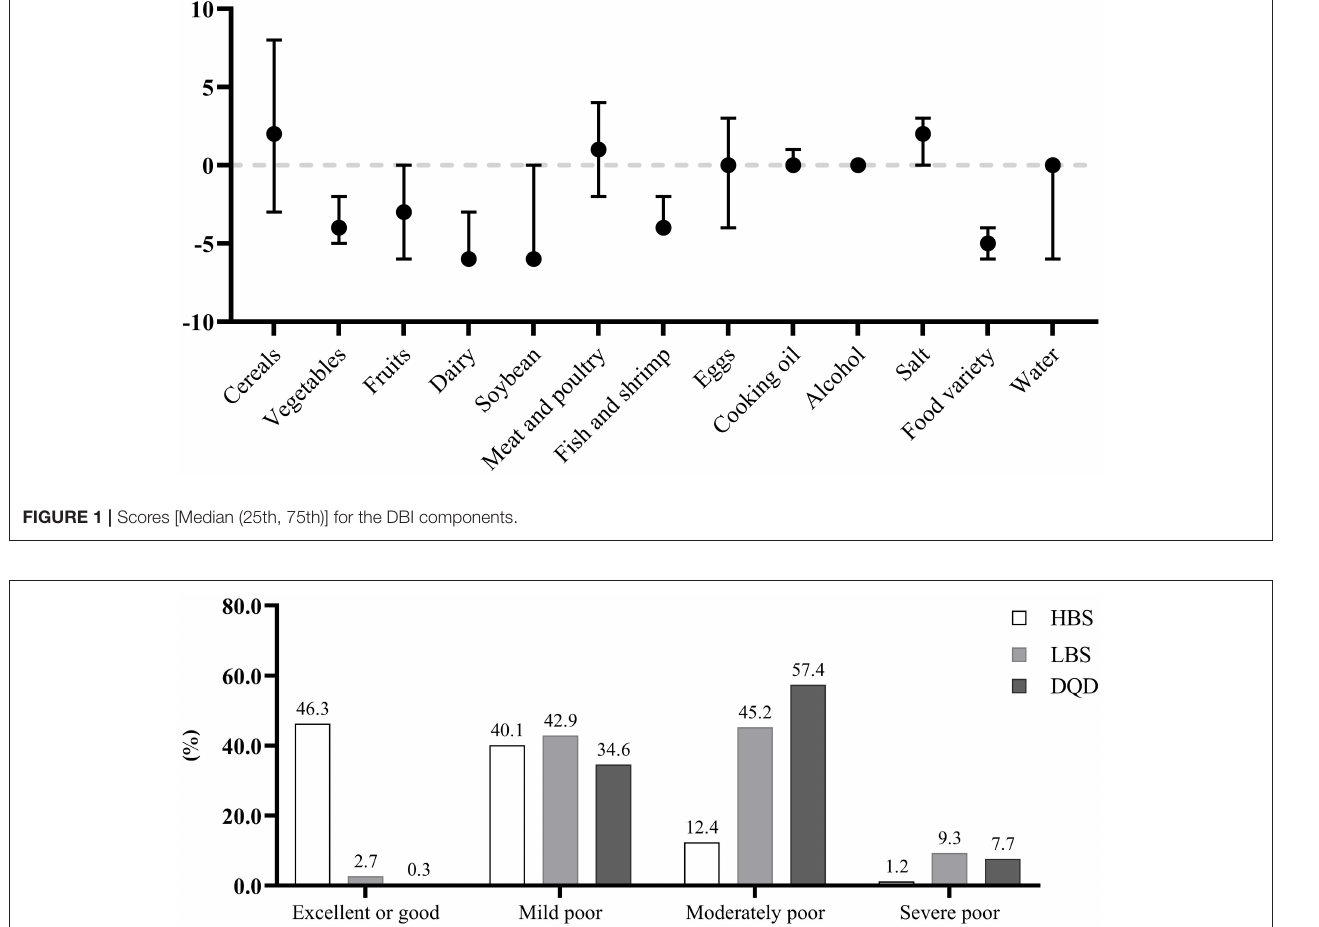
Frontiers in Nutrition |